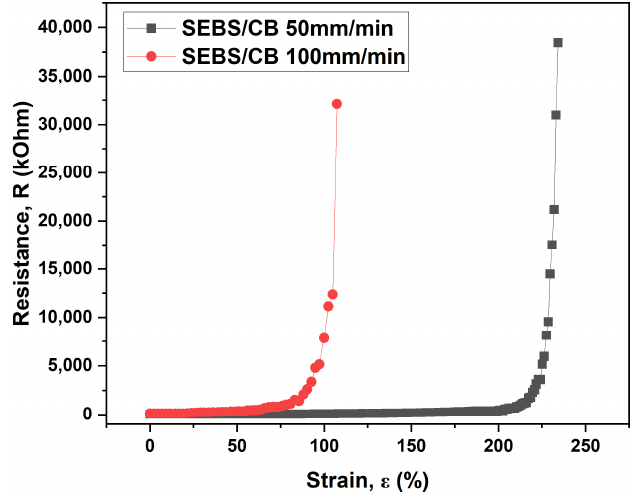
Figure 5. Electro-mechanical properties of the SEBS/CB 15% at different elongation rates.